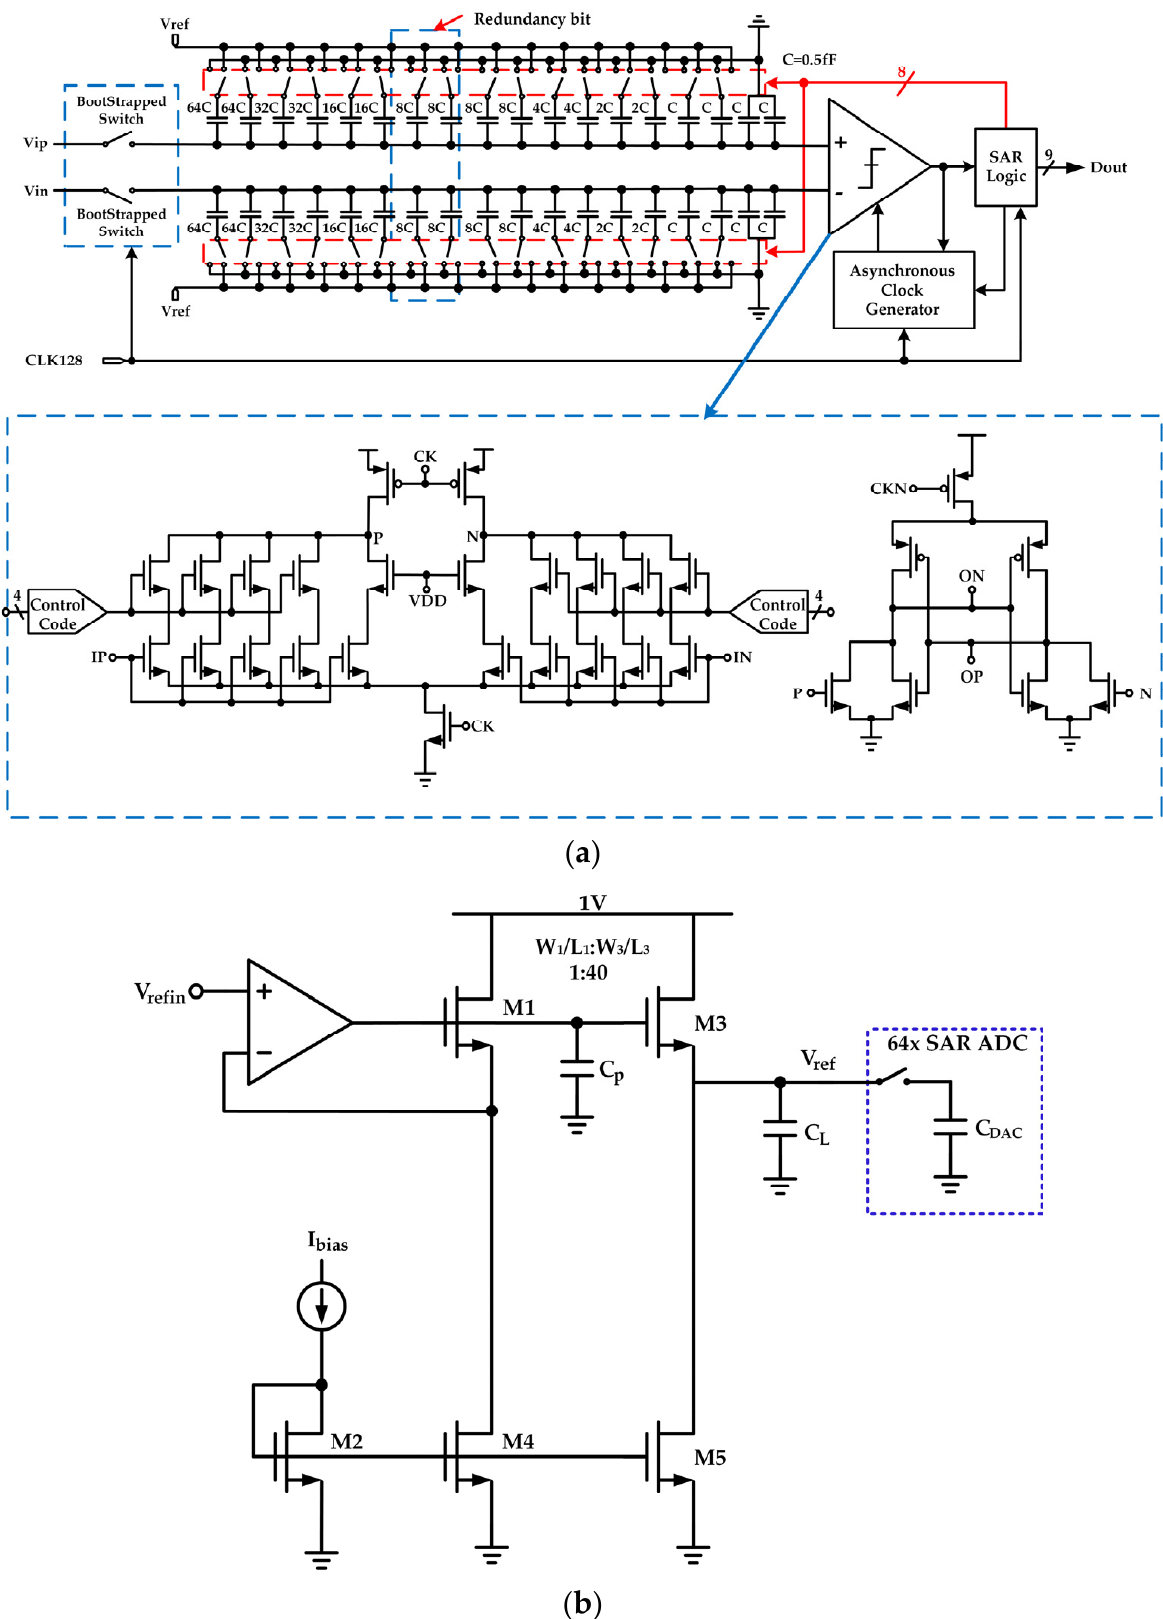
Figure 3. ( a ) SAR ADC details. ( b ) Reference voltage generation circuit.